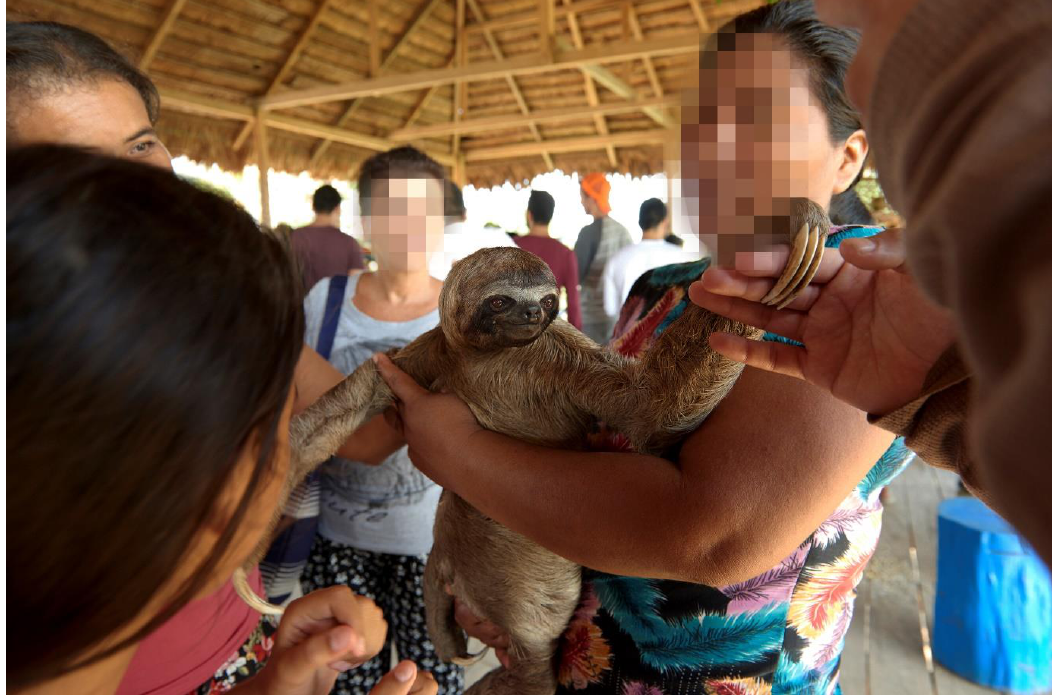
Figure 1. Platform in Puerto Alegria, where tourists are offered direct contact with sloths. Photograph taken by Fernando Carniel Machado. Table 1. Number of sloths, focal observations, and total observation length at each location.